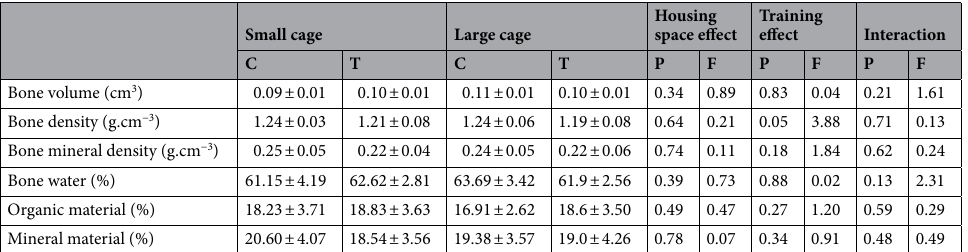
Table 1. Bone volume (cm 3 ), bone density (g.cm −3 ), bone mineral density (g.cm −3 ), percentage of water, organic and mineral materials from the animals’ femur for the control (C) and trained (T) groups kept in small cage (SC) and large cage (LC). Data are in mean ± standard deviation (SD). Statistical analysis: We used two-way ANOVA for identifying the effects of housing space and training and housing space and post-hoc Newman Keuls to trace differences among groups.